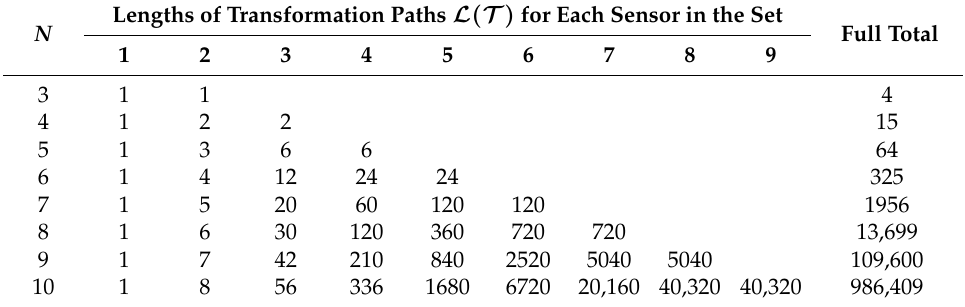
Table 1. Number of paths of the several lengths of the transformation paths for a given number of sensors N , and the full total of transformation paths in each set of sensors. The full total in each row is obtained